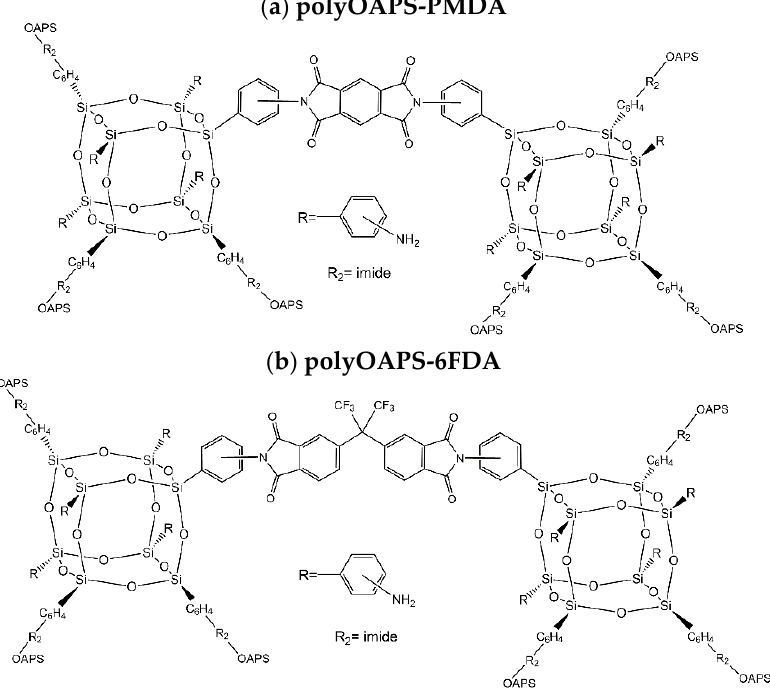
Figure 2. The general chemical formula of polyOAPS-imide networks based on ( a ) the PMDA and ( b ) the 6FDA organic precursors, with an average connectivity of four links per OAPS cage.